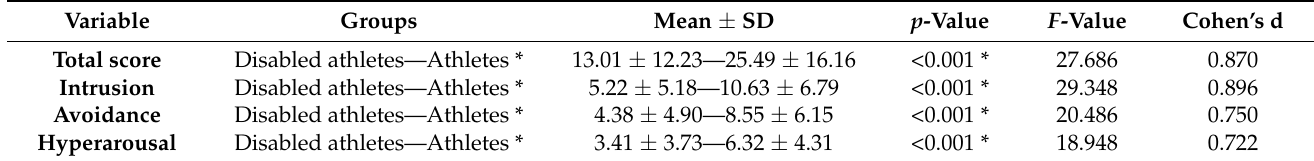
Table 4. Comparison between disabled athletes and athletes for IES-R